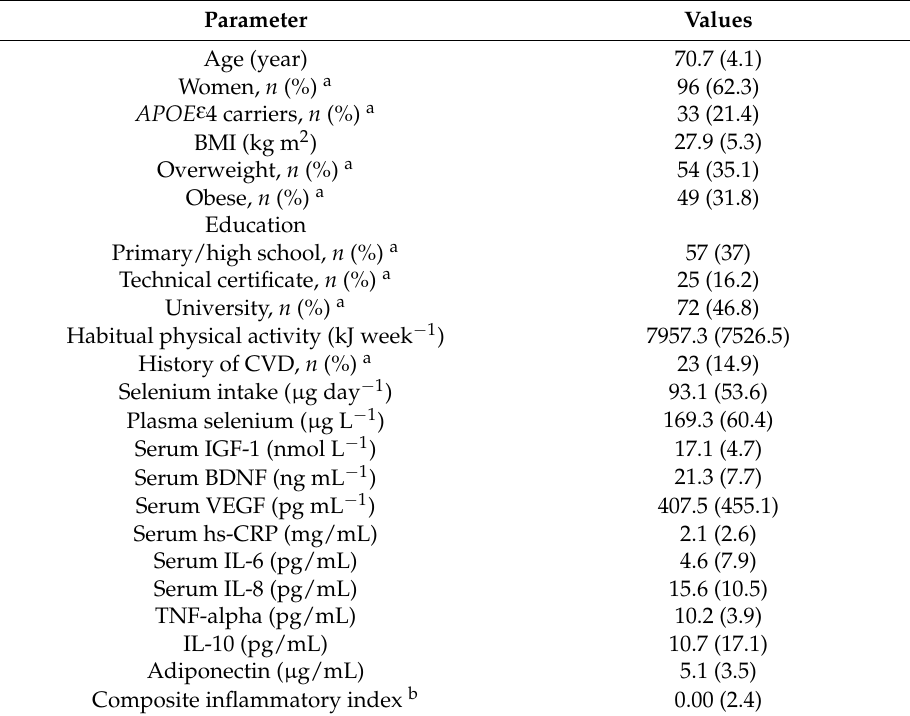
Table 1. Population characteristics ( n =